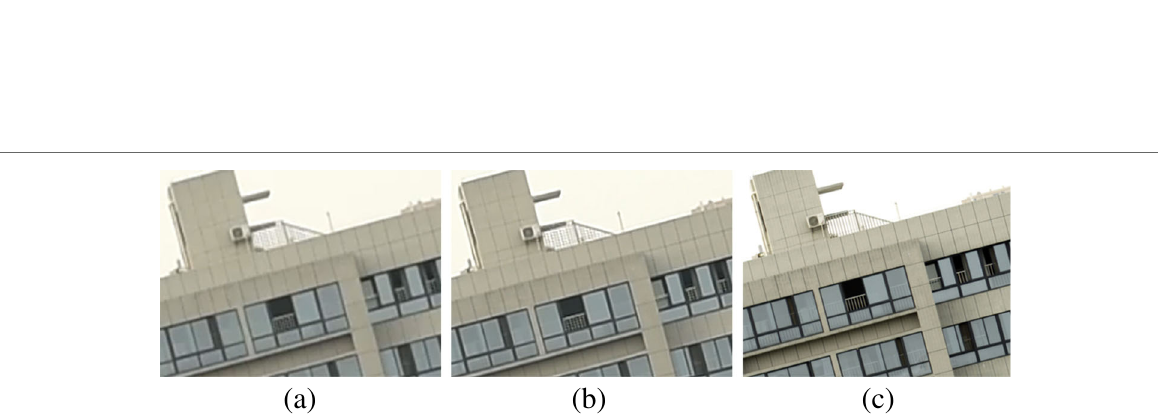
Fig. 8 Super-resolution of building images. a One bicubic-interpolated LR image with an up-sampling factor equal to 2. b Reconstructed HR image by OSR with an up-sampling factor equal to 2. c Ground-truth